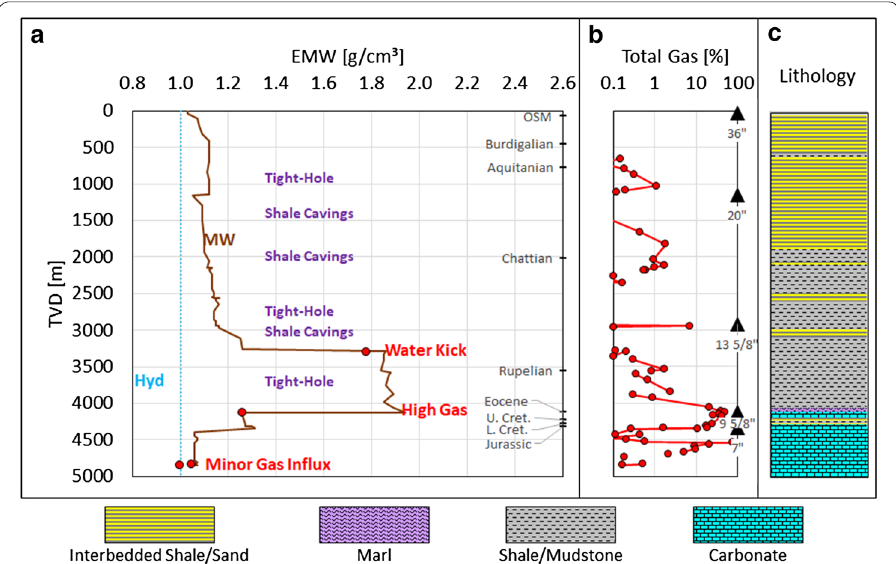
Fig. 3 Graphical representation of the drilling history and drilling-related pressure indicators of the Geretsried GEN-1 well. a Pressure in equivalent mud weight (EMW) in g/cm 3 vs. true vertical depth (TVD) with drilling mud weight MW (brown line), hydrostatic pressure Hyd (blue dotted line), influx events (red dots and annotations), other overpressure indications (purple annotations) and stratigraphic tops. b Total gas readings while drilling on a logarithmic scale in percent (red lines and dots) and casing shoe points (black triangles). c Simplified lithological profile based on cutting descriptions from the geological well report (legend on the bottom provides key for